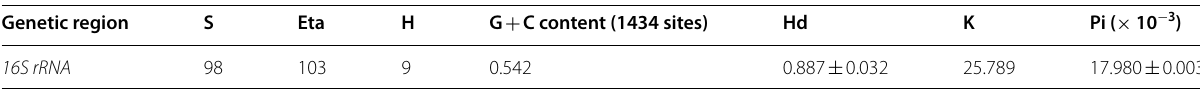
S, Number of variable sites; Eta, Total number of mutations; H, Number of haplotypes; Hd, haplotype (gene) diversity; Pi, nucleotide diversity (per site); k, average number of nucleotide differences